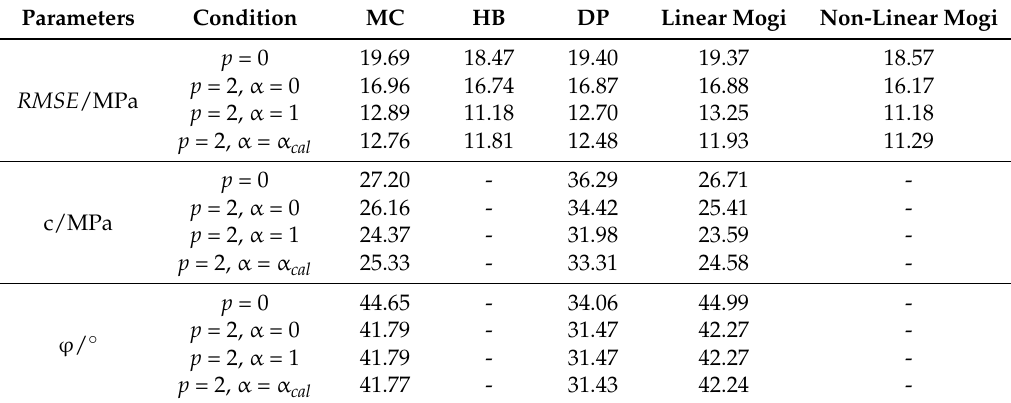
Table 2. Calculated values of five failure criteria ( p stands for pore gas pressure).